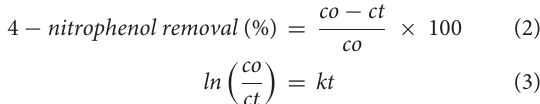
Frontiers in Chemistry |